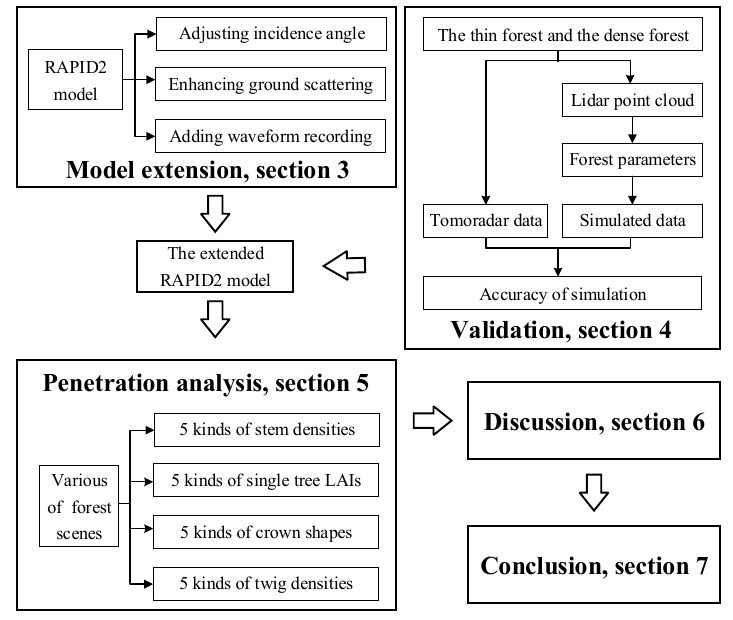
Figure 1. The general framework of this paper.